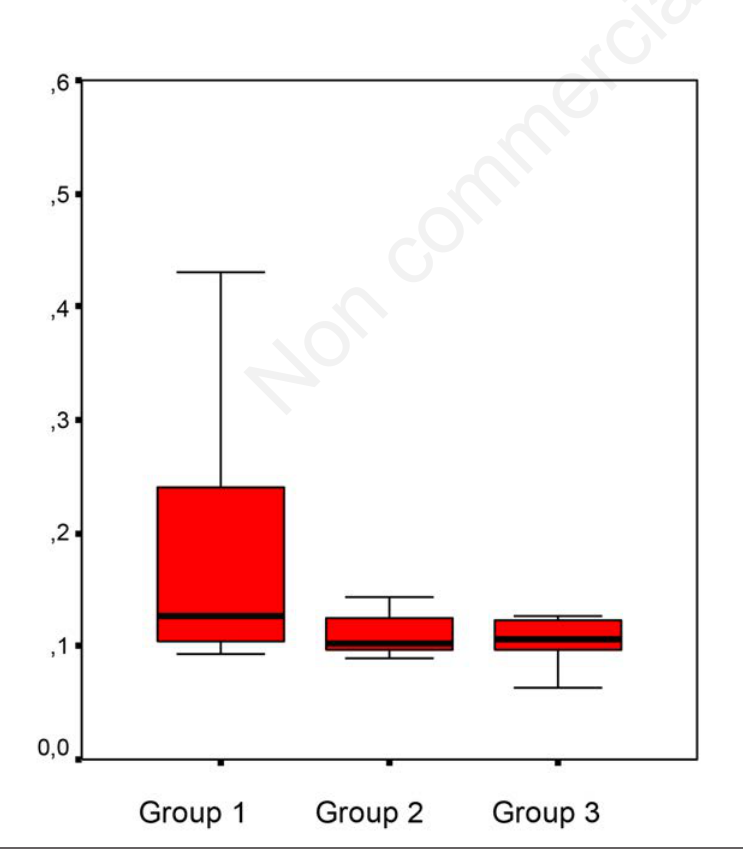
Figure 1. Serum endocan levels in study groups (group 1: children with febrile neutrope- nia; group 2: leukemia children without fever/neutropenia; group 3: healthy